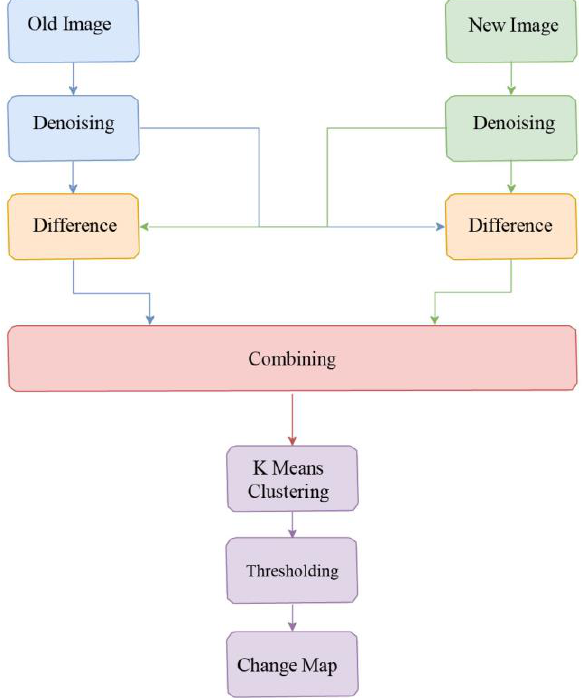
Figure 6. Workflow diagram for unsupervised change